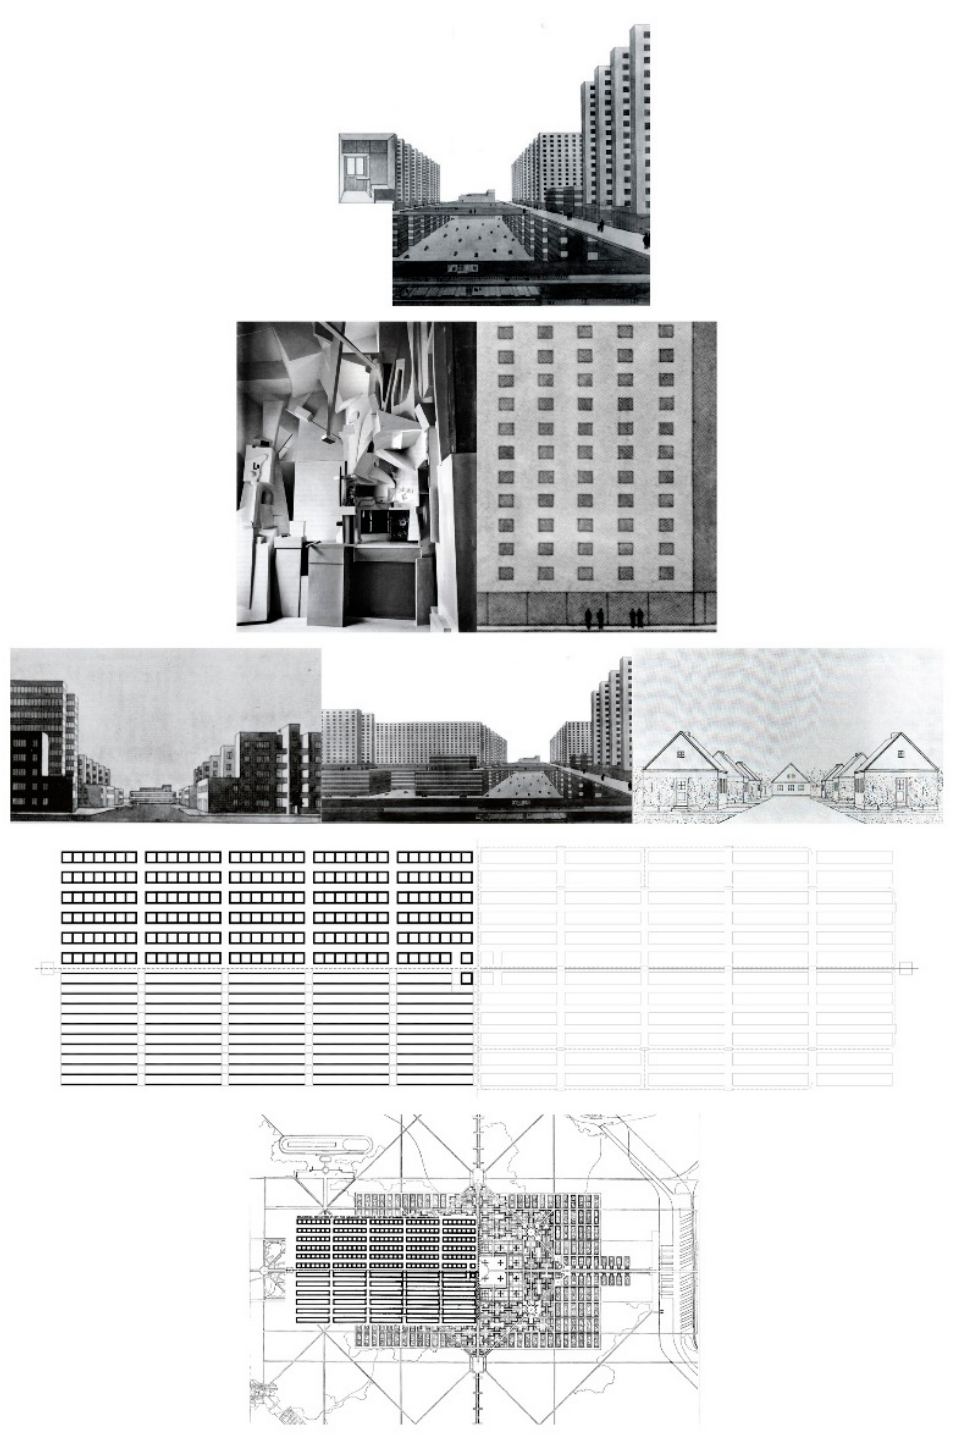
Figure 1. Montage panel by author. While art avant-gardes represented the intensity of the city through collage and assemblage of multifarious elements, Hilberseimer sought to internalise the shock of the metropolis and distilled the “nervous energy” into a language of formally reduced elements and typical forms that could be produced and reproduced in generic schema—an architectural analogue (or analogical form) of Georg Simmel’s blasé attitude.